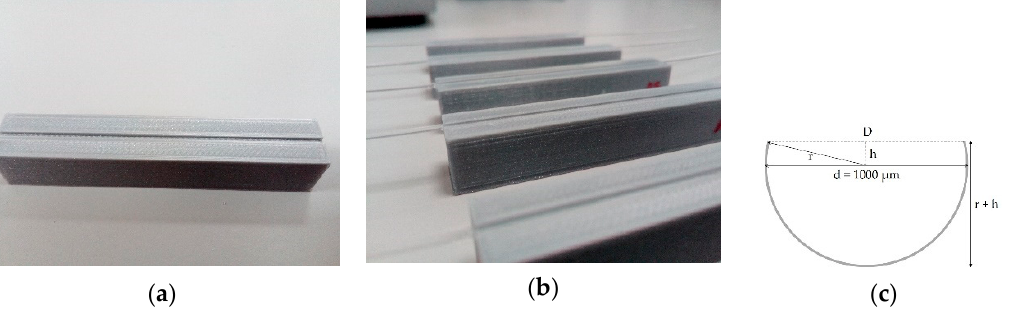
Figure 1. ( a ) Platform used for embedding the prepared fibers (groove dimensions: 6.0 cm, 1.1 mm, 0.7 mm); ( b ) produced D-shaped plastic optical fiber (POF) sensors ( c ) schematic representation of the D-shaped POF ( (cid:1856) is the POF diameter, (cid:1870) the radius, and (cid:1830) the obtained surface thickness).